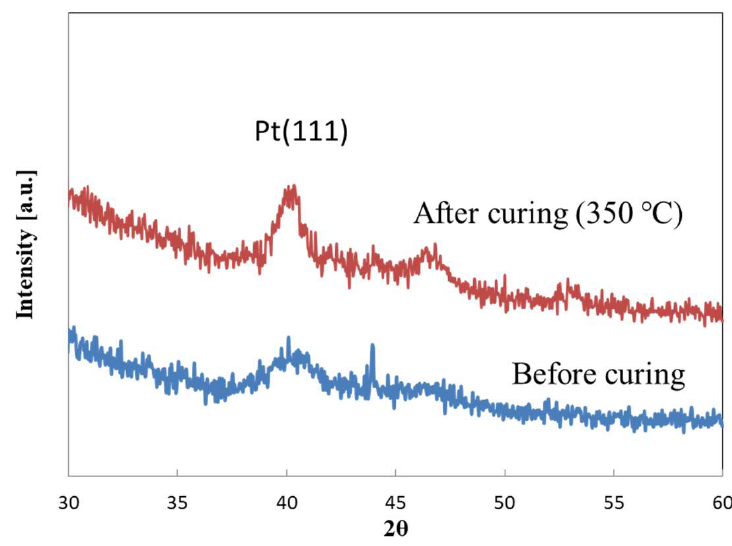
Figure 3. XRD patterns of the Pt catalyst before and after the heat treatment.